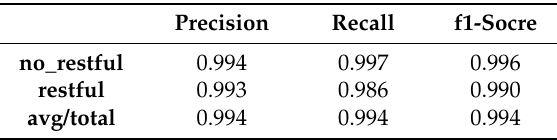
Table 3. Classification results without FPSR.